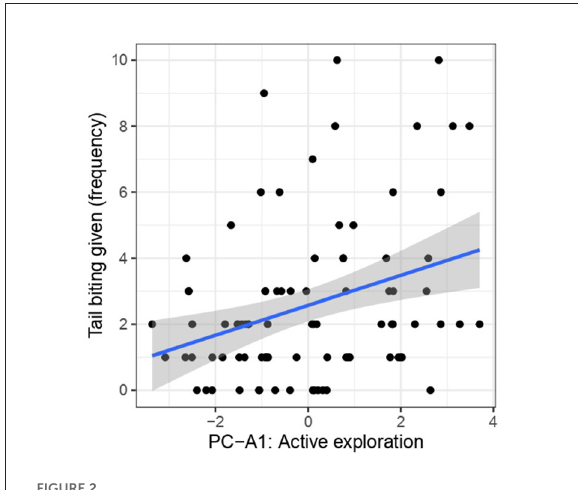
FIGURE2 The relationship between tail biting given and PC-A1 “Active exploration.”